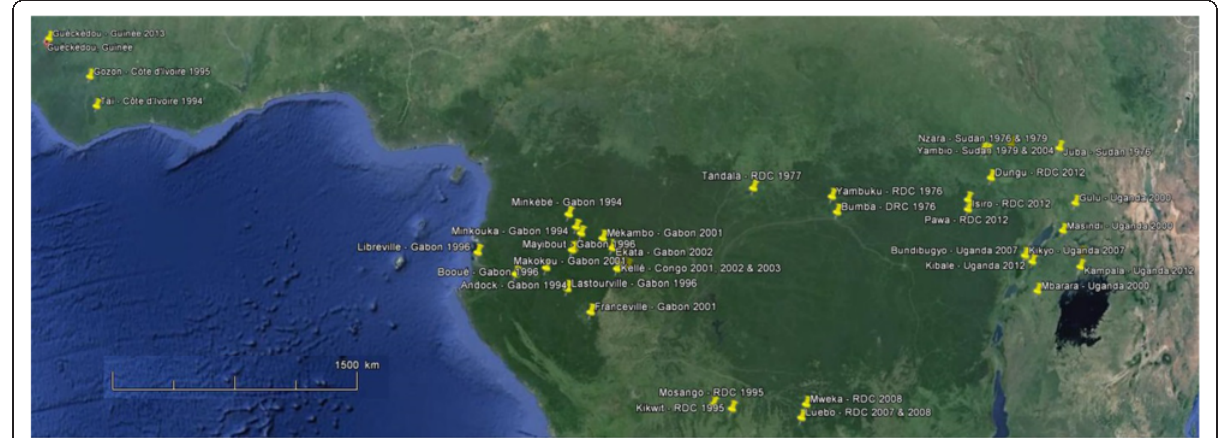
Figure 5 Geographical distribution of African manifestations of Ebola viruses (based on Google ™ Earth